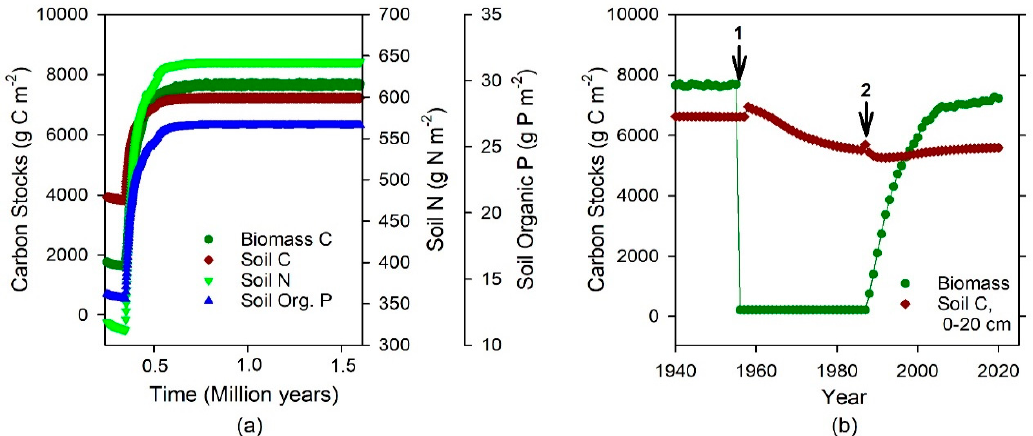
Figure 1. Baseline spin-up of Century model simulations of biomass C and soil C, N, and P (0–20 cm) stocks for La Selva Biological Station, Costa Rica. ( a ) Mature forest development over 1.5 million years. ( b ) Land-use changes appended to baseline are denoted by arrows. (1) Mature forest was felled and burned in 1955, pasture grass planted and pasture was grazed. (2) Pasture was abandoned in 1987, grass was cut and mulched, and experimental trees were planted in mono-dominant plantations in 1988. Results here depict the same tree species, ‘mature forest’ (La Selva Mature, LSM, as in Table S2), modeled both before deforestation and during the experimental plantation period.